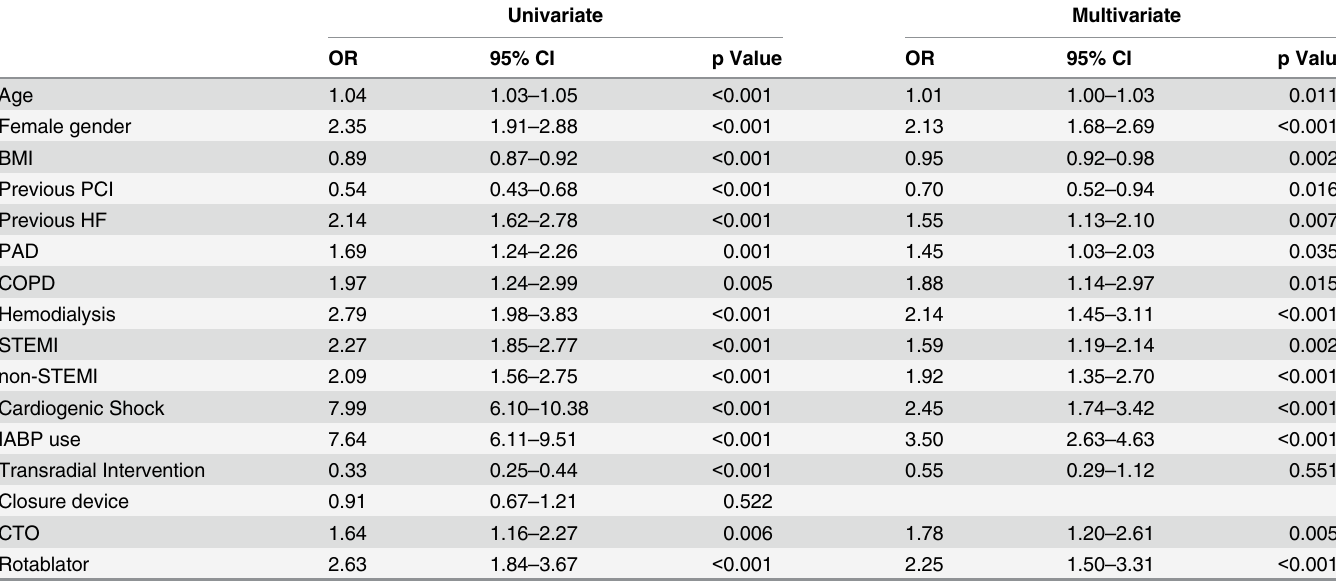
Table 6. Multivariate Logistic Regression Analysis on Bleeding Complications within 72 Hours in the Total Cohort.